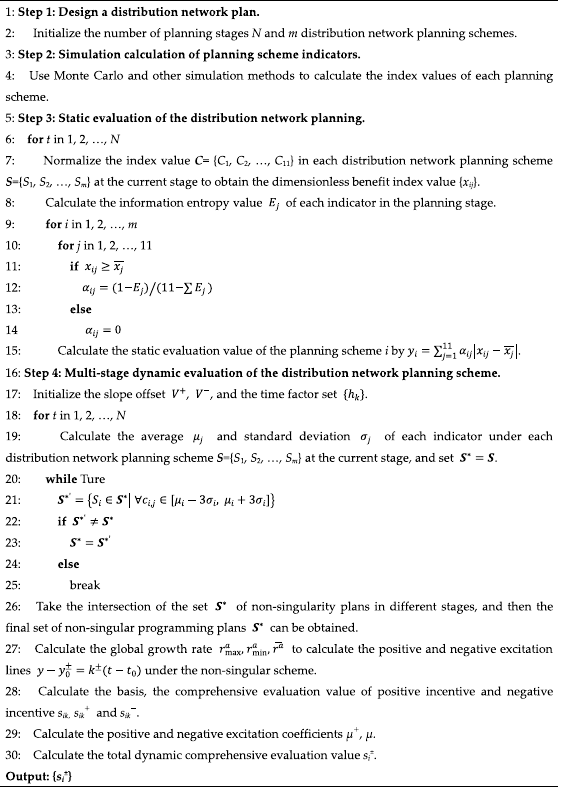
Algorithm. 1A dynamic evaluation method of distribution network planning schemes based on dual excitation control lines